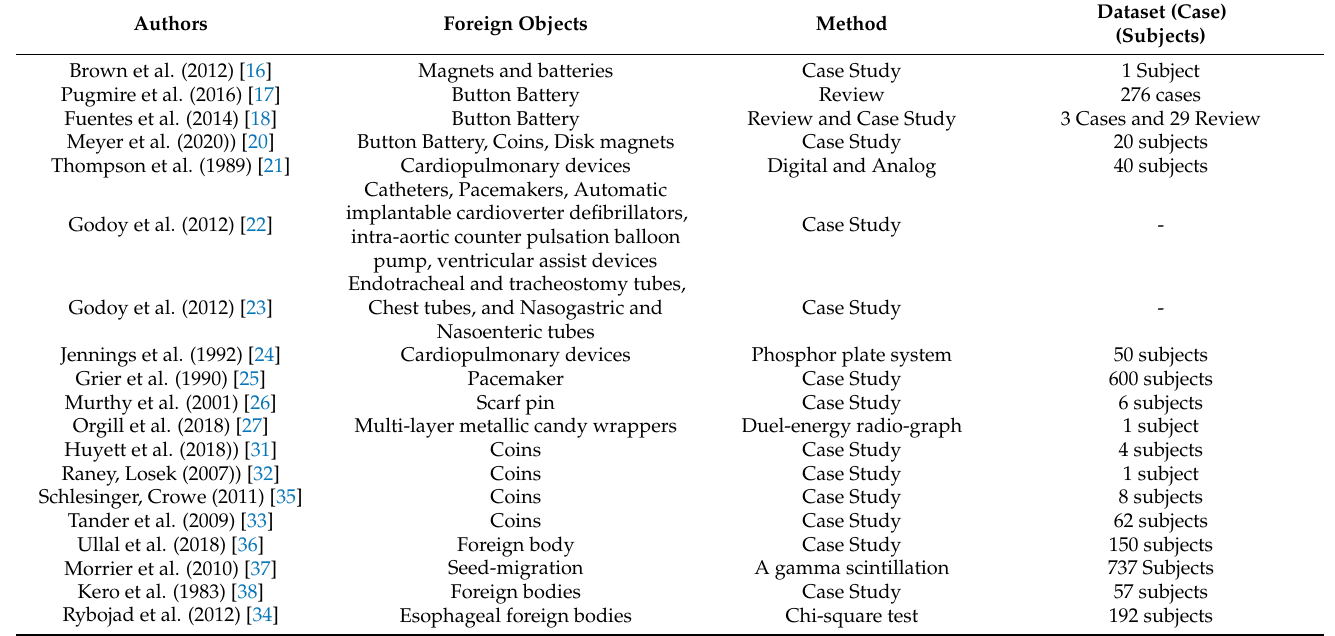
Table 1. Foreign objects in chest X-rays (clinical observation) dataset (cases and